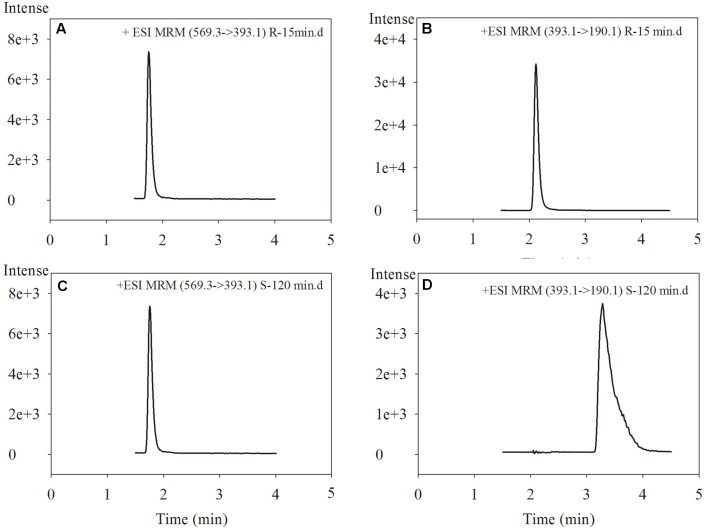
The chromatograms of R(+)-NAF-G (A), R(+)-NAF (B), S(–)-NAF-G (C), and S(–)-NAF (D) in human liver microsome after incubation of R(+)-NAF for 15 min and of S(–)-NAF for 120 min.